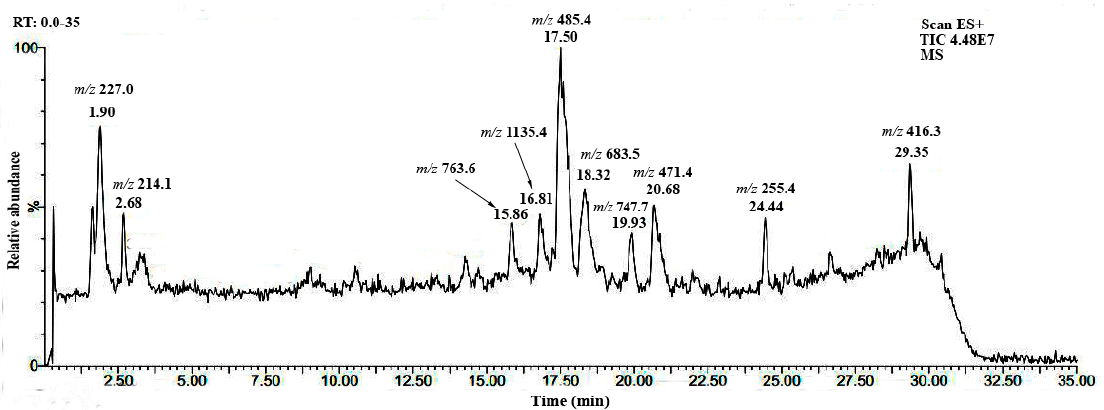
Figure 3. Total ion chromatogram of crude saponin of H. atra showing the mass spectrum (MS) values of major components.